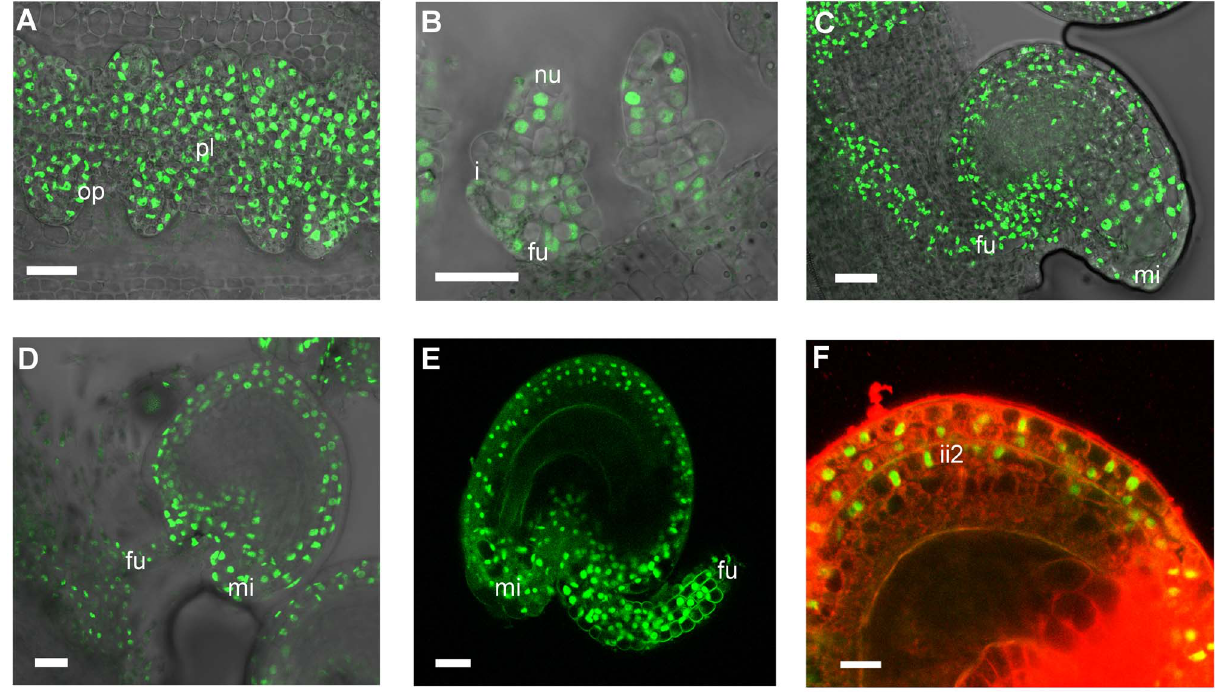
Fig. 6. Confocal laser-scanning images of pSTK::STK-GFP expression patterns during ovule and seed development. ( A ) Early ovule development: STK-GFP nuclear protein is expressed in the placenta and in the ovule primordia. ( B ) When integuments arise STK-GFP signal is localized in the nucellus and in the funiculus. ( C , D ) Mature ovule development: GFP can be detected throughout the integuments, funiculus and the adjacent placental region. ( E ) After fertilization the STK-GFP signal is present in the outer integuments and funiculus of developing seeds. ( F ) Magnification of figure E with an overlay projection images of specific PI staining to determine the presence of the GFP signal in the integuments. Protein can be detected in the two layers of the outer integument and also in the more external layer of the inner integument. op, ovule primordia; pl, placenta; nu, nucellus; i, integuments; fu, funiculus; mi, micropyle; ii2, internal layer of inner integument. Scale bars=50 m m ( A and B ), 40 m m ( C , D and E ) and 20 m m ( F